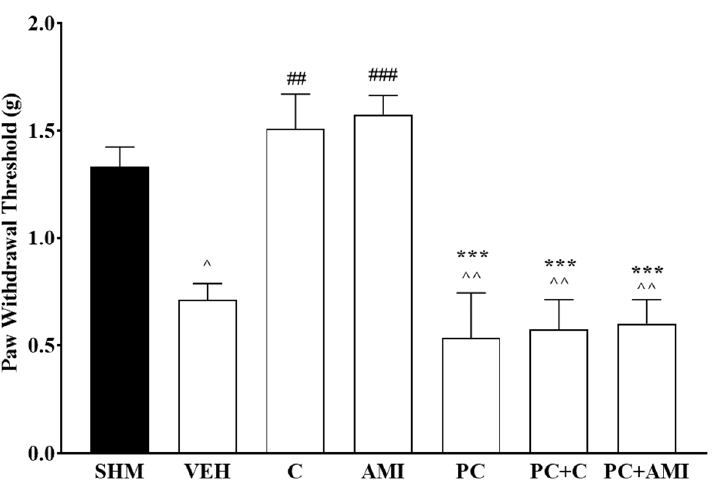
Figure 2. Effect of ρ - chlorophenylalanine (PCPA, a serotonin synthesis inhibitor) pre-treatment on cardamonin against mechanical allodynia of CCI-induced neuropathic pain mice were evaluated using von-Frey filament test. Data were presented as mean ± SEM ( n = 6). The caret, hash, and asterisks denote the significance levels (one-way ANOVA, followed by Tukey’s post hoc test. ^ p < 0.05 as compared to the sham, ^^ p < 0.01 as compared to sham, ## p < 0.01, ### p < 0.001 as compared to vehicle and *** p < 0.001 as compared to cardamonin-treated group. SHM (Sham); VEH (Vehicle, 10 mL/kg i.p.); C (Cardamonin, 10 mg/kg i.p.); AMI (Amitriptyline, 20 mg/kg i.p.); PC ( ρ - chlorophenylalanine, 100 mg/kg